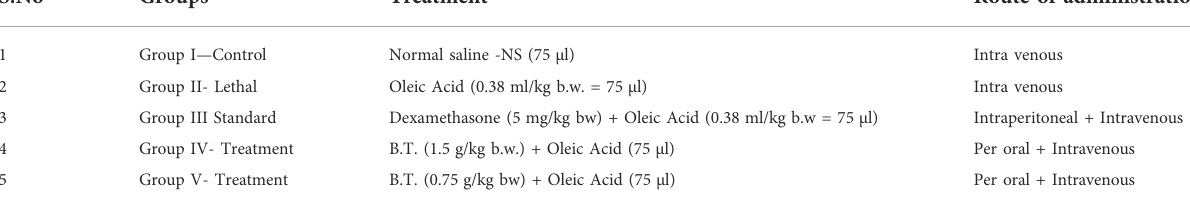
TABLE 2 Division of groups.